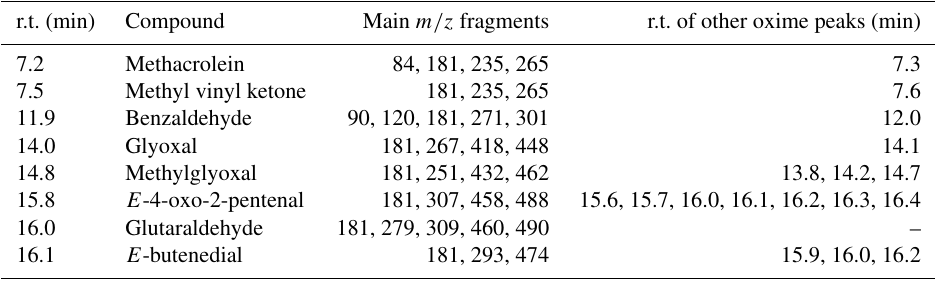
Table 2. Description of chromatographic peaks detected after the on-fibre derivatization using PFBHA as reagent for the carbonyl and α -dicarbonyl compounds selected.